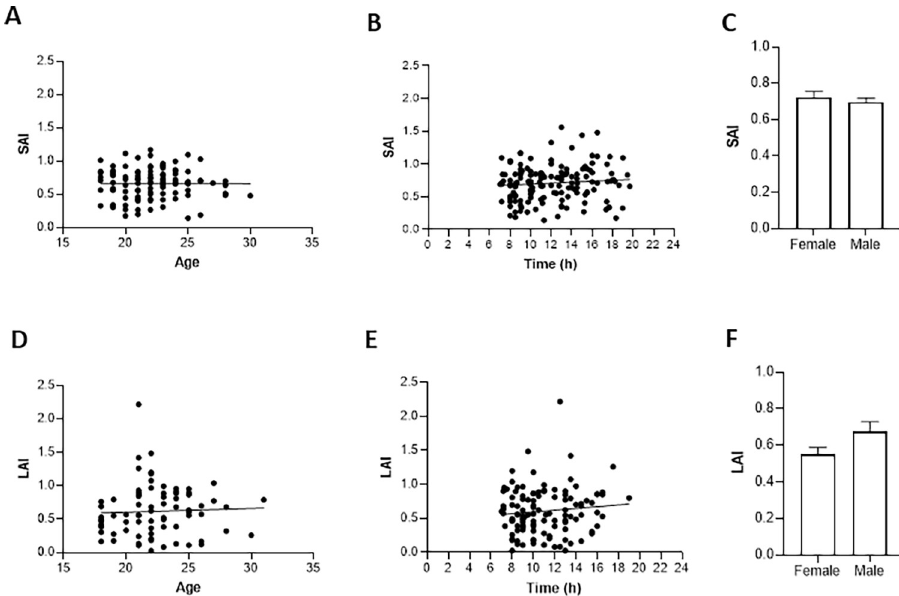
Fig 3. Correlations and gender comparisons for SAI and LAI data. Nonsignificant correlations of SAI with age (18– 35 years; n = 113), and time of day (n = 148) are shown in A and B respectively. No difference in SAI with respect to biological sex is shown in C. Similarly, LAI did not correlate with age between 18 and 35 years (D; n = 81), or time of day (E; n = 117) and was not different between males and females (F). All error bars reflect standard error of the mean.